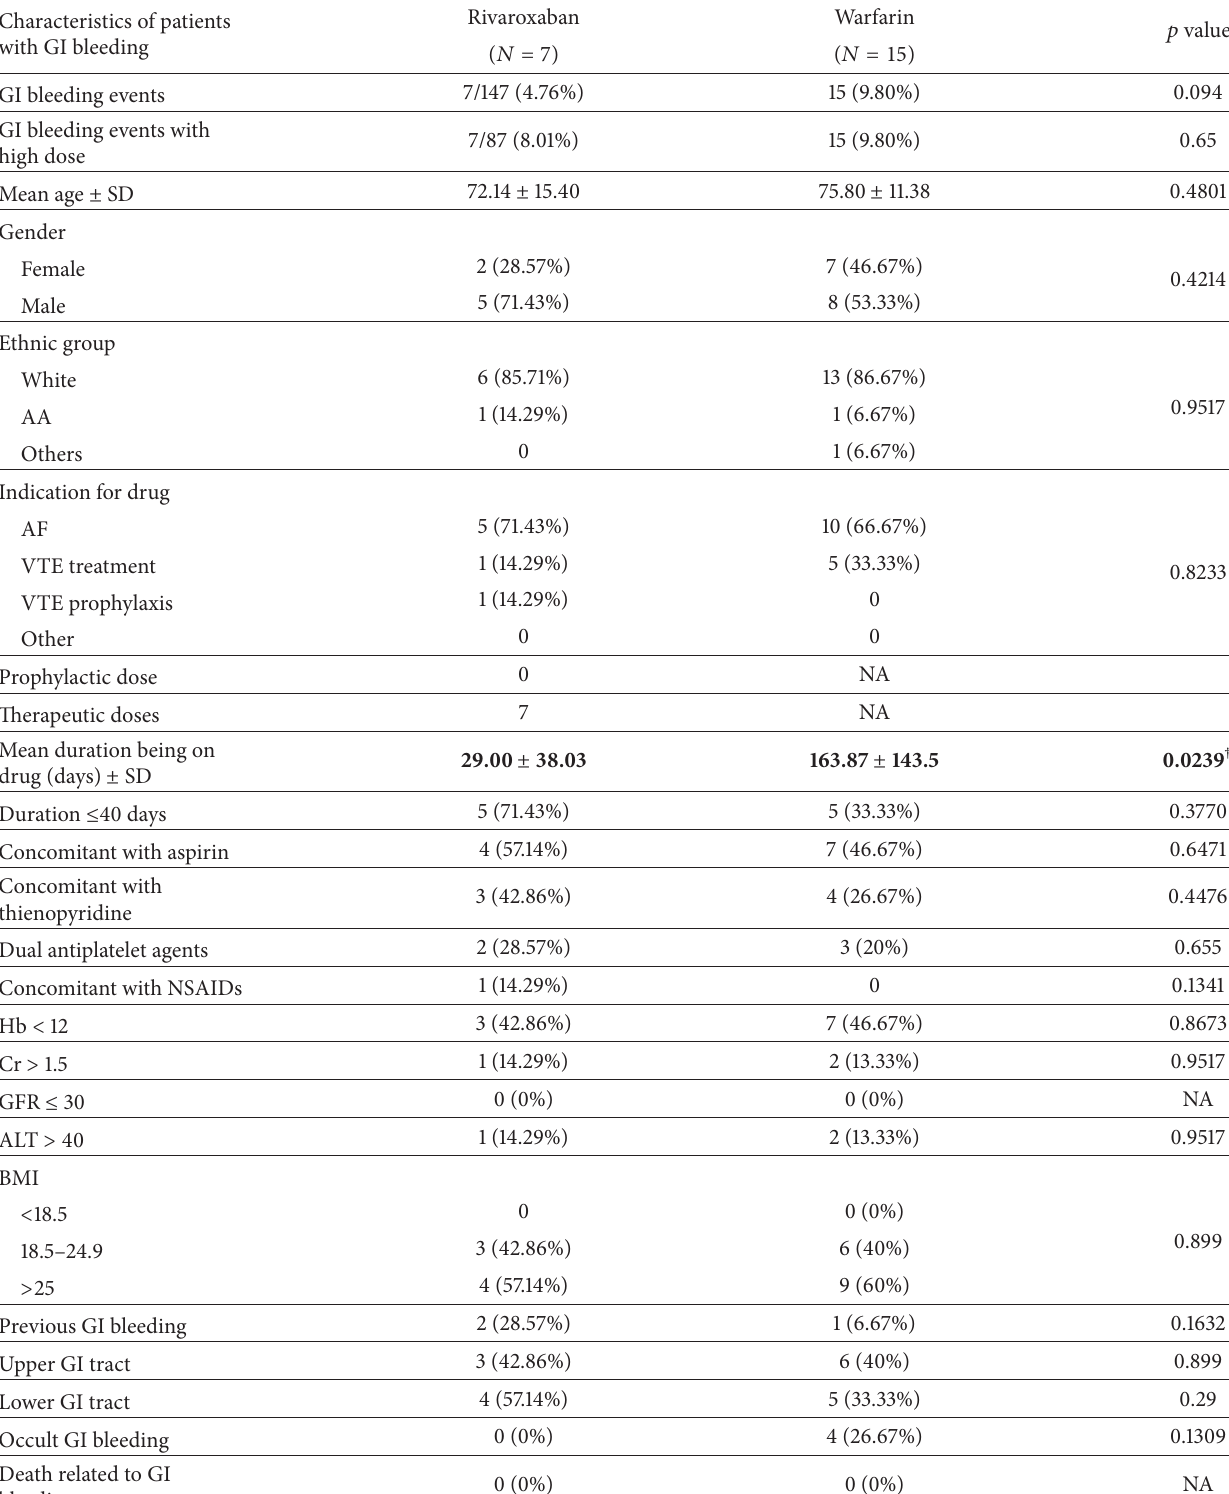
Table 3: Demographic and clinical characteristics of patients with GI bleeding in both groups. Characteristics of